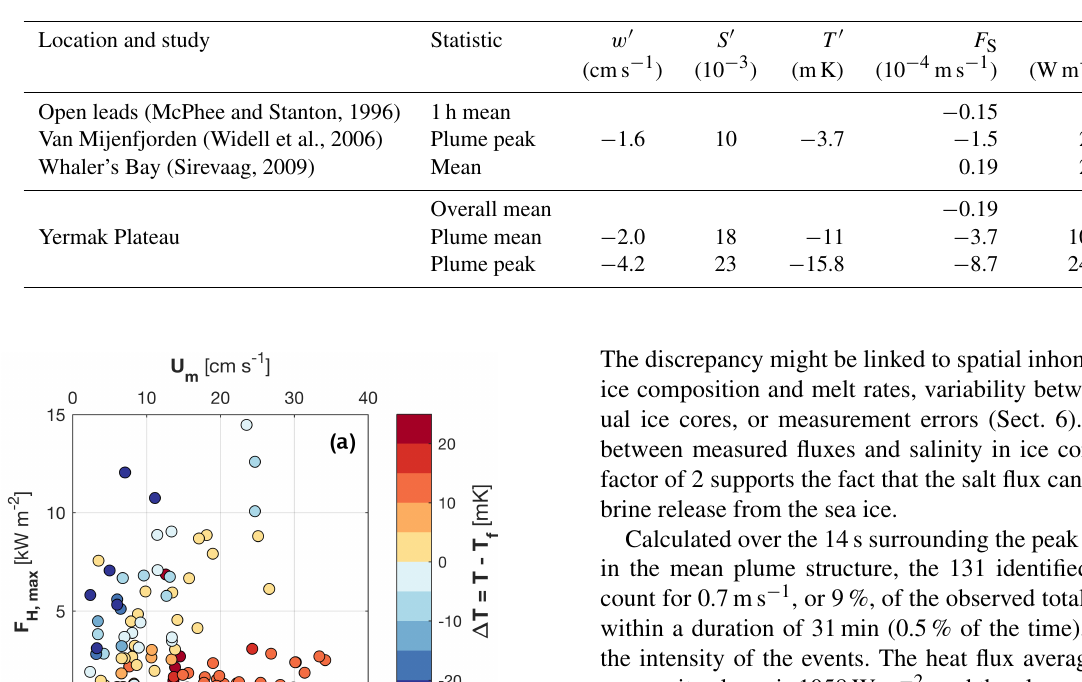
Table 1. Statistics of fluctuations and turbulent fluxes in the present study over the Yermak Plateau in comparison with other Arctic studies of turbulent heat and salt fluxes.